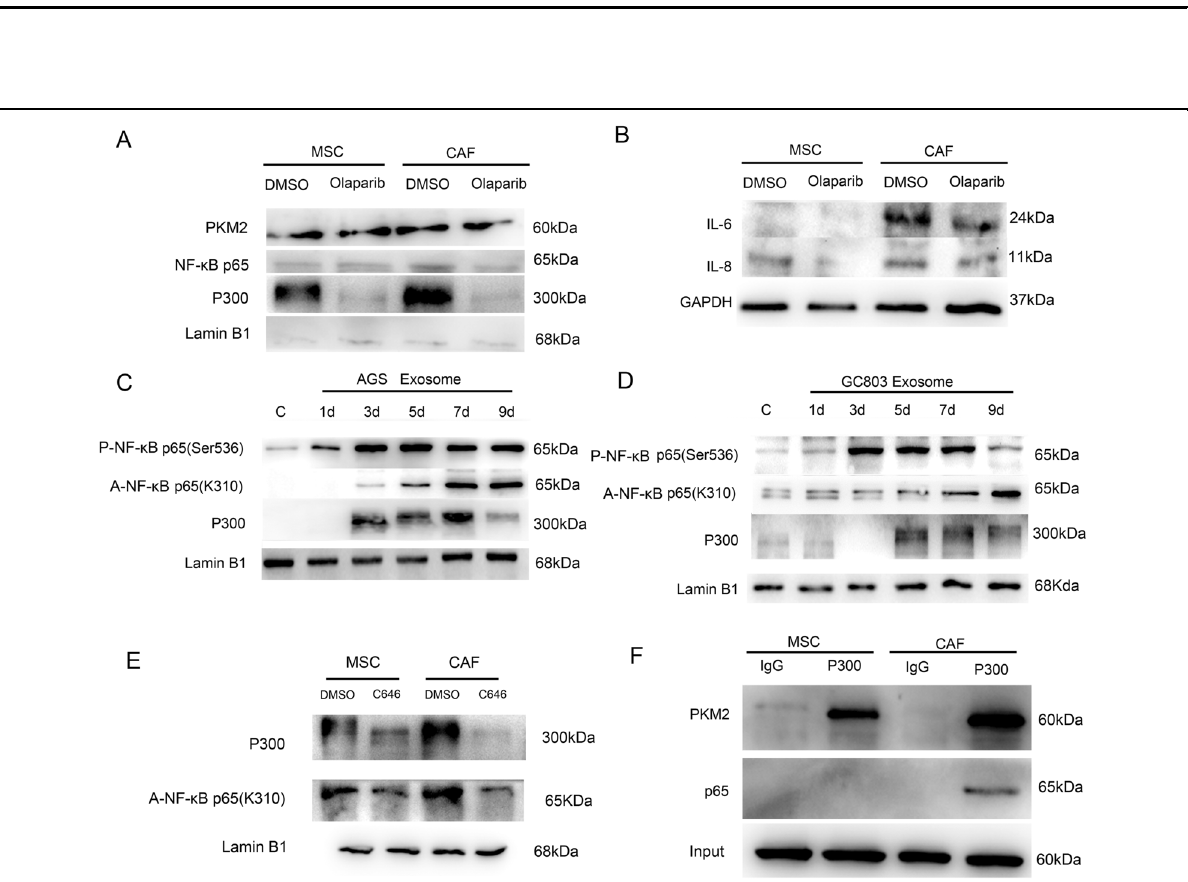
Fig. 6 Mechanism of PKM2 promoting NF- κ B P65 retention in the nucleus. A Western blotting detected nuclear protein expression in CAFs(AGS exosomes-treated) after adding PKM2 nuclear translocation inhibitor olaparib. B Western blotting detected in fl ammatory factor expression in CAFs (AGS exosome treated) after the addition of the PKM2 nuclear translocation inhibitor olaparib. C , D Western blotting detected nuclear protein expression during the differentiation of MSCs into CAFs. E Acetylated P65 expression in the nucleus of MSCs and CAFs (AGS exosome treated) after the addition of the P300 inhibitor C646. F Co-IP: P300 antibody captured PKM2 and P65 in the whole-cell lysates of MSCs and CAFs (AGS exosome